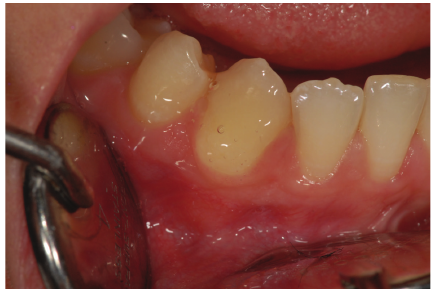
Figure 5: GaAlAs laser application + NaF gel